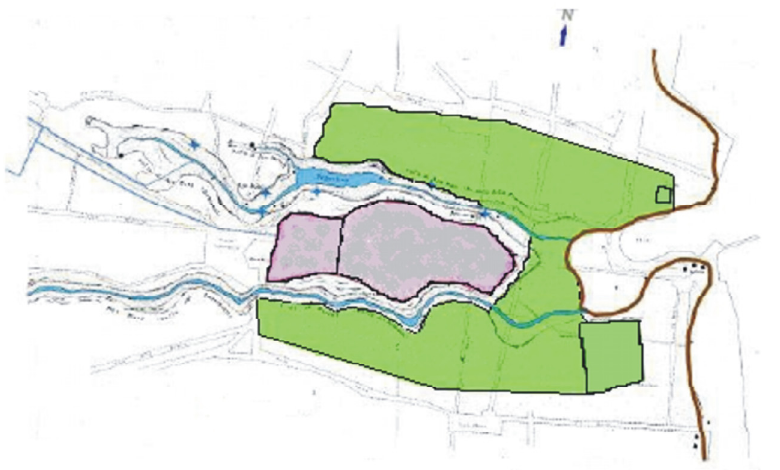
Figure 2. Layout of Palermo: historical center (purple area); urban expansion during Arab period (green